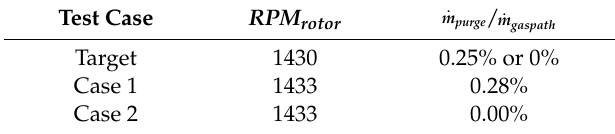
Table 2. The two experimental test cases along with target speed and purge flow rate.